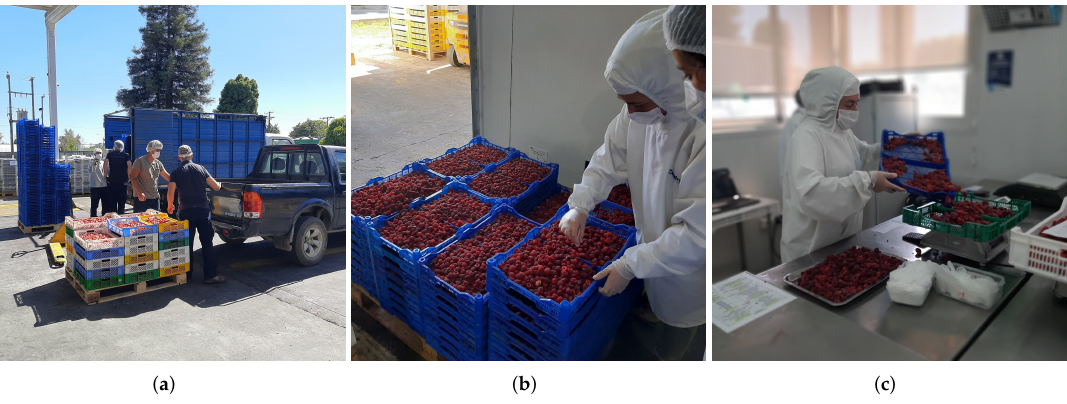
Figure 1. Harvested fresh fruit that enters the industry’s selection and quality control process. ( a ) Fruit reception. All harvested fresh fruit is received for the quality control process. ( b ) Fruit selection. Harvested fresh fruit is visually checked before choosing a random sample to be inspected. ( c ) Fruit sample. One kilogram of red raspberries is selected as a sample unit from an entire